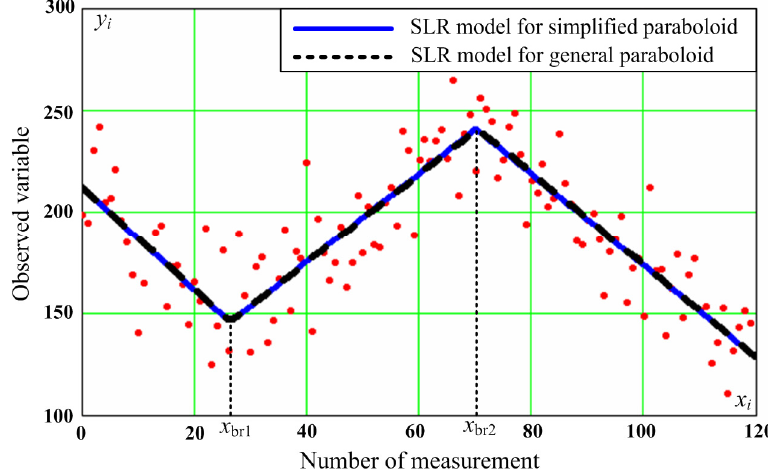
Figure 5. Generated dataset and final optimal SLR models.